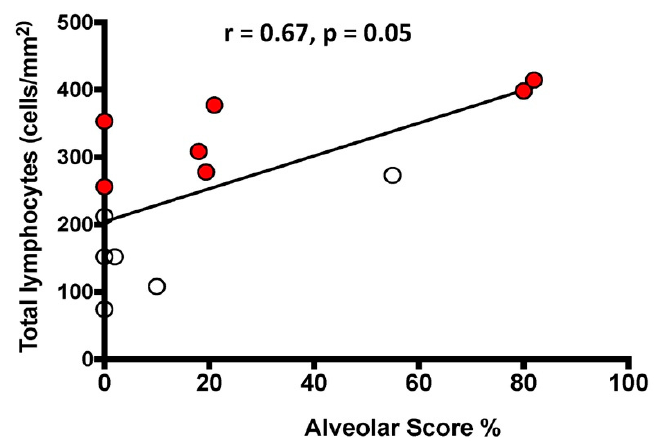
Figure 3. Relationship between the number of total lymphocytes infiltrating the lung tissue and the HRCT Alveolar Score. The black line represents the correlation in the entire population. White circles indicate slow progressors and red circles rapid progressors. Spearman’s rank correlation: r = 0.67, p = 0.01 in the entire population; r = 0.33, p = 0.48 in slow progressors alone; r = 0.81, p = 0.03 in rapid progressors alone.